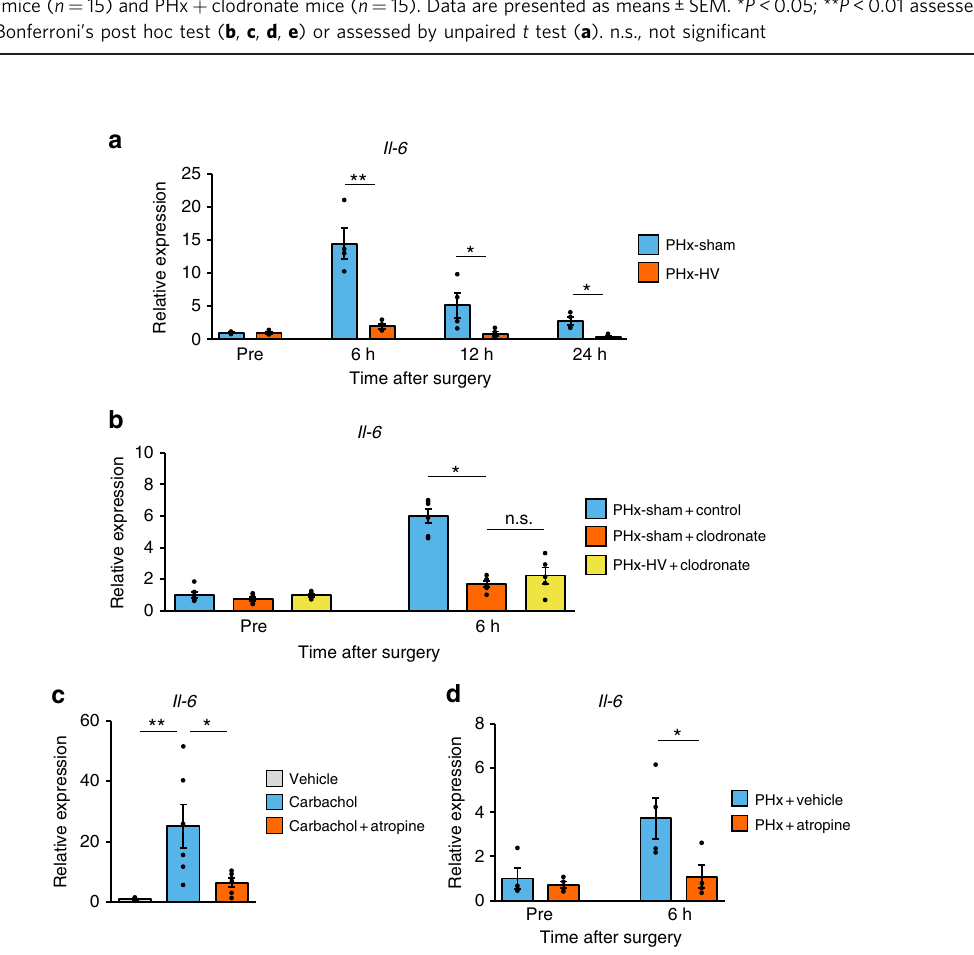
Fig. 5 Macrophages mediate vagus-induced hepatic FoxM1 activation. a (Upper panels) Representative images of liver sections immunostained for F4/80 from mice 24 h after receiving control and clodronate liposomes. Scale bars indicate 100 µ m. (Lower panel) Relative gene expressions of F4/80 in the liver 24 h after control ( n = 4) and clodronate ( n = 4) liposome administration. b Relative expressions of Foxm1 , its target genes, and MKi67 in the liver 2 days after surgery in SO + control mice ( n = 6), PHx-sham + control mice ( n = 8), PHx-sham + clodronate mice ( n = 6), and PHx-HV + clodronate mice ( n = 6). c (Left panels) Representative images of liver sections immunostained for BrdU on day 2 in SO + control-, PHx-sham + control-, PHx-sham + clordronate-, and PHx-HV + clodronate mice. Scale bars indicate 100 µ m. (Right panel) BrdU-positive hepatocyte ratios in SO + control mice ( n = 6), PHx- sham + control mice ( n = 8), PHx-sham + clodronate mice ( n = 6,) and PHx-HV + clodronate mice ( n = 6) 2 days after surgery. d Relative expressions of Foxm1